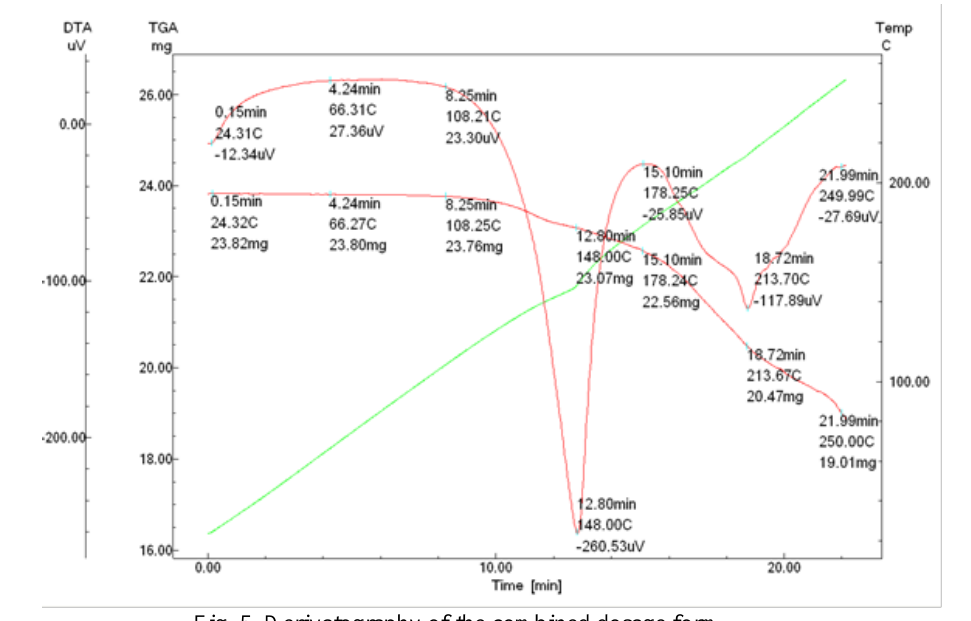
Fig. 5. Derivatography of the combined dosage